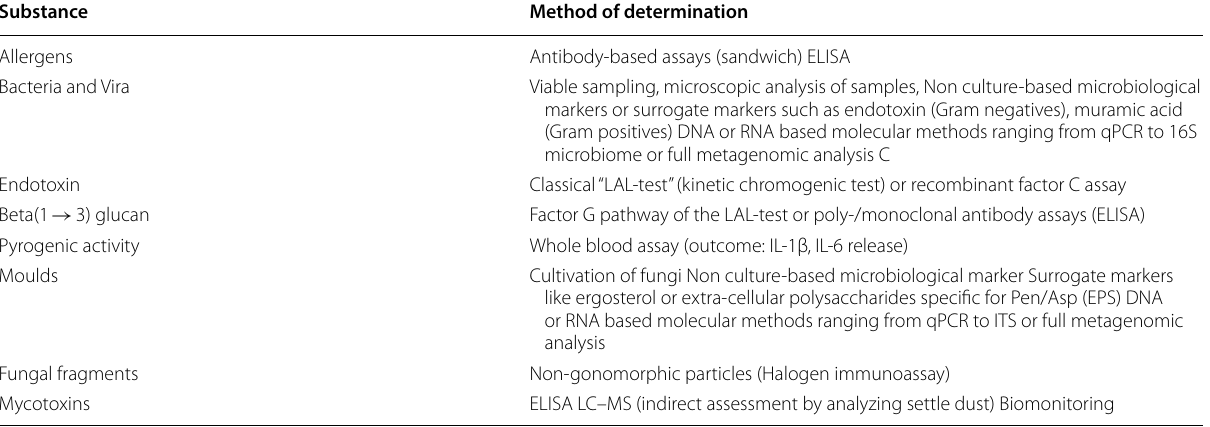
Table 4 Bioaerosol-components in farming environment